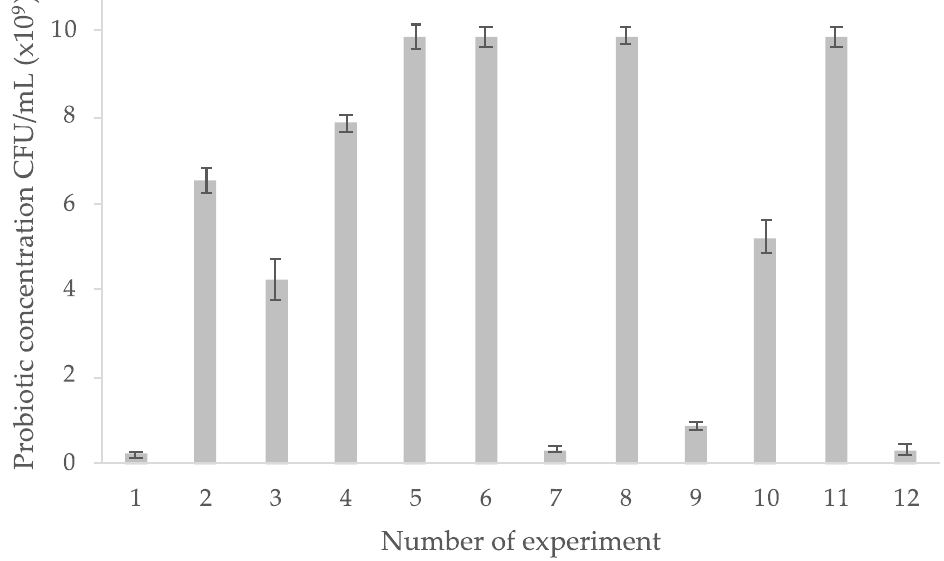
Figure 1. Influence of the initial concentration of inoculum and β -glucan (according to the experi- mental design) over L. rhamnossus GG growth.